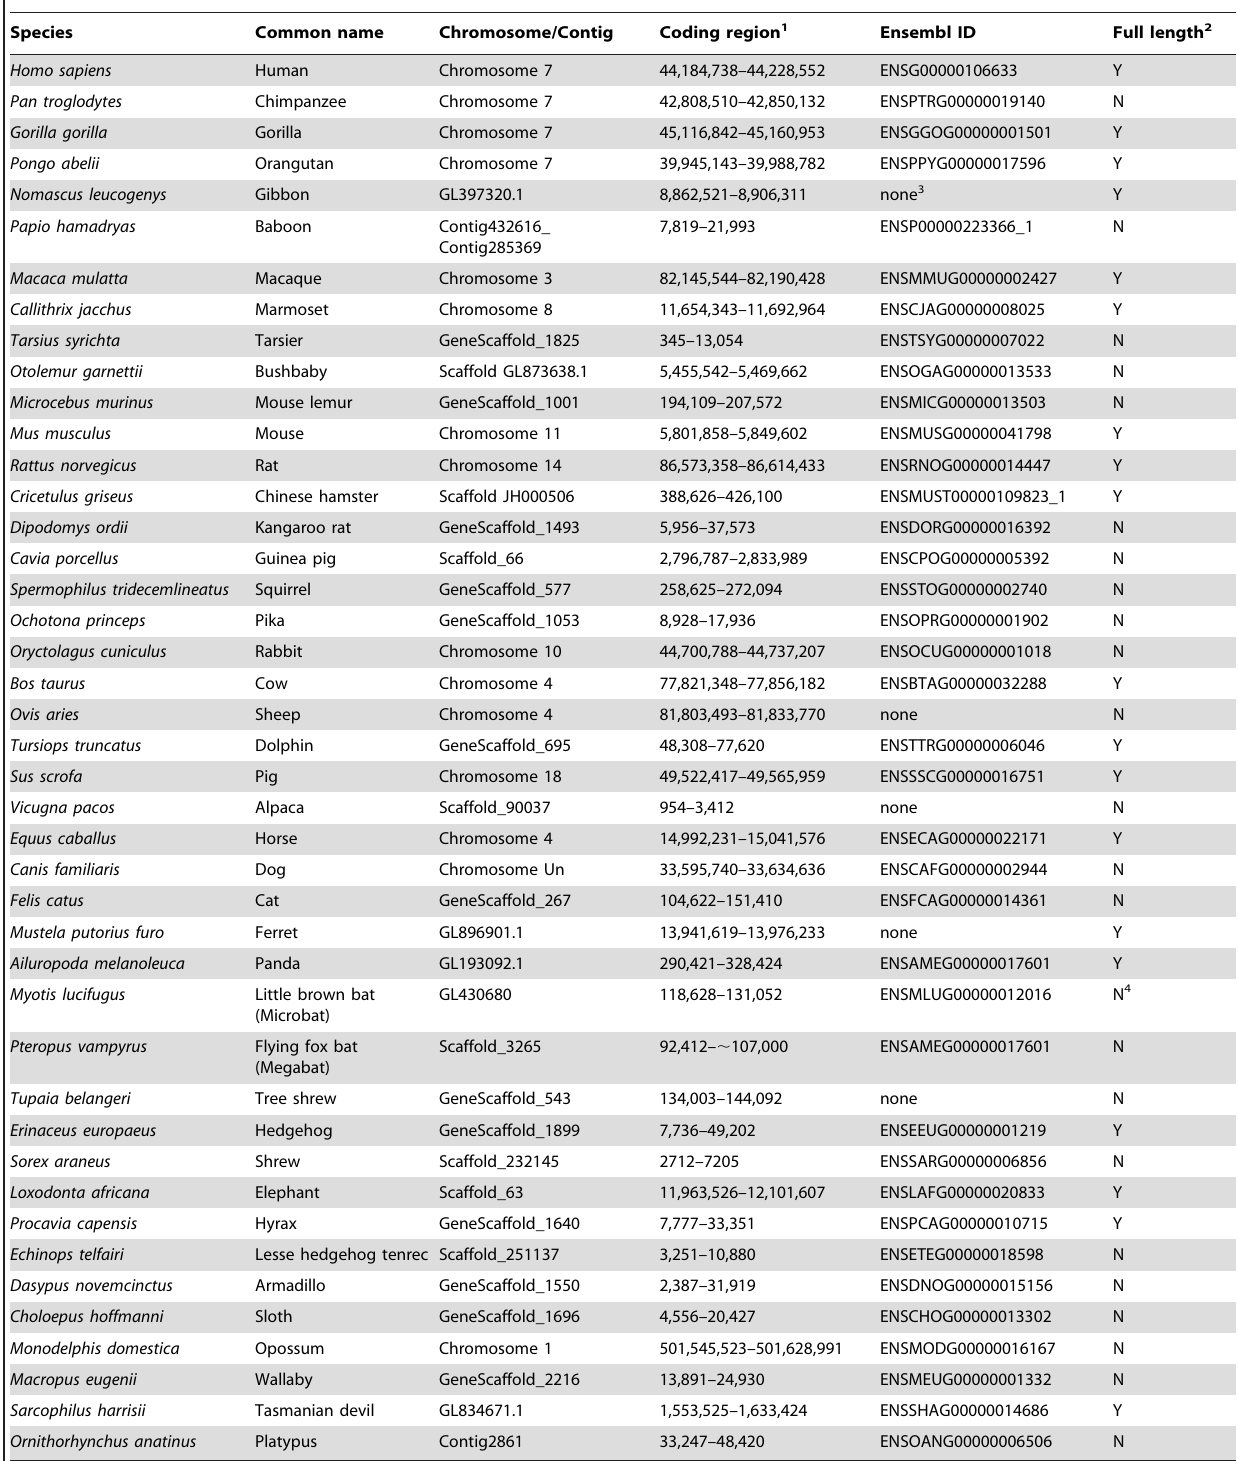
Table 1. Genomic locations of glucokinase genes in diverse mammalian